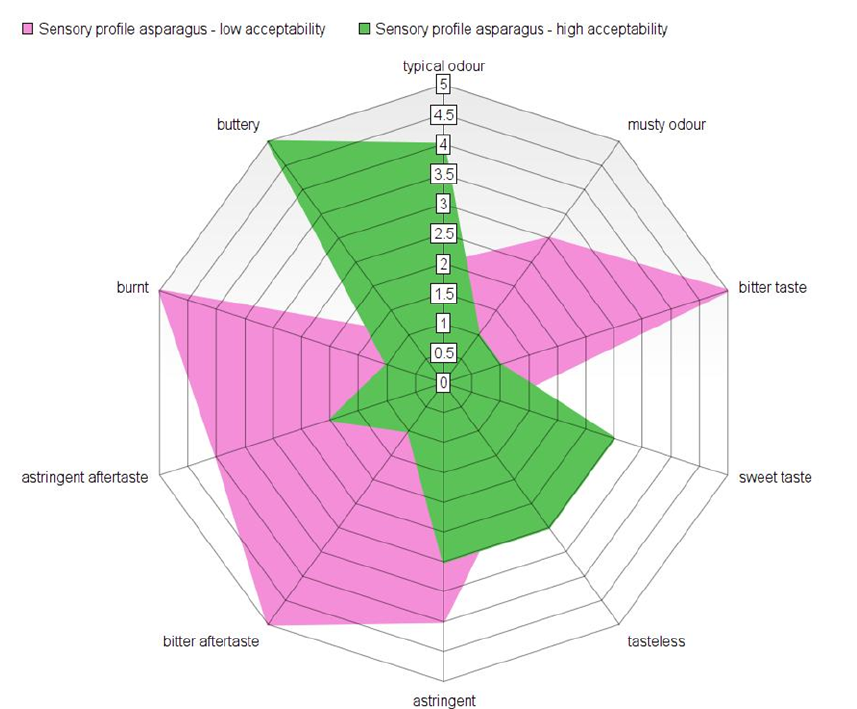
Figure 3. Re-worked summary of the data from [97].The sensory profile of asparagus with low (pink) and high (green) acceptability as was calculated based on the average of the sensory profiles of 12 different cultivars in Europe in 2004. The typical odour corresponds to the right balance of compounds and aroma attributes presented in Table 2 and Figure 4. The musty odour is basically due to unbalanced ratios of C8 ketones and alcohols, based on the findings of